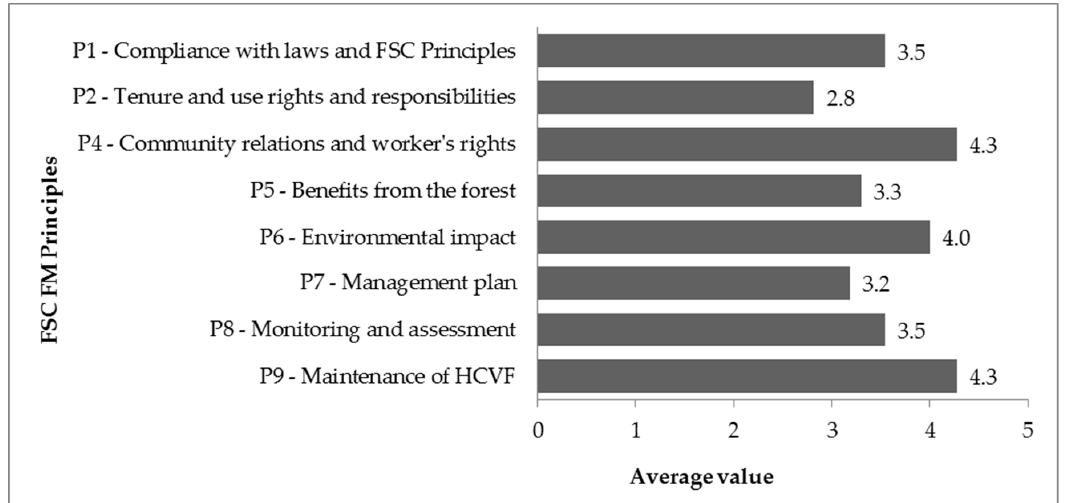
Figure 6. The average values of FSC principles contribution to SFM.